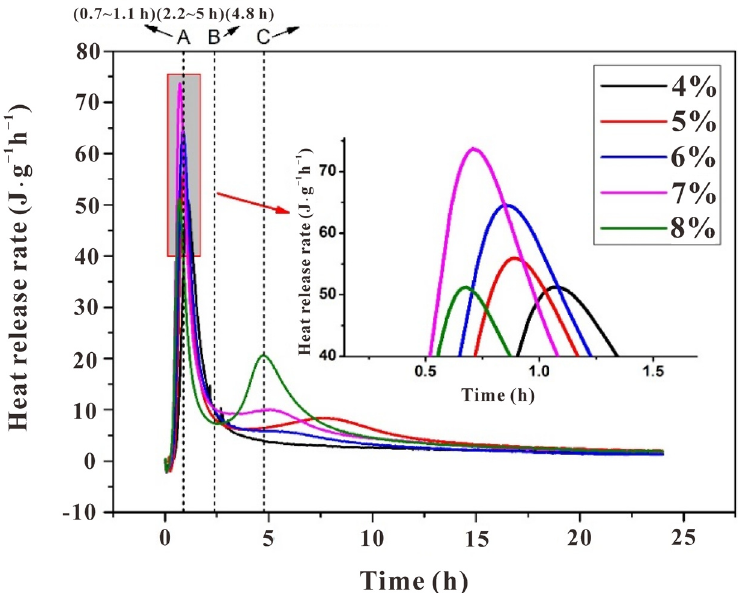
Figure 8. Effect of alkali content on heat release of an early-age slag-based geopolymer.